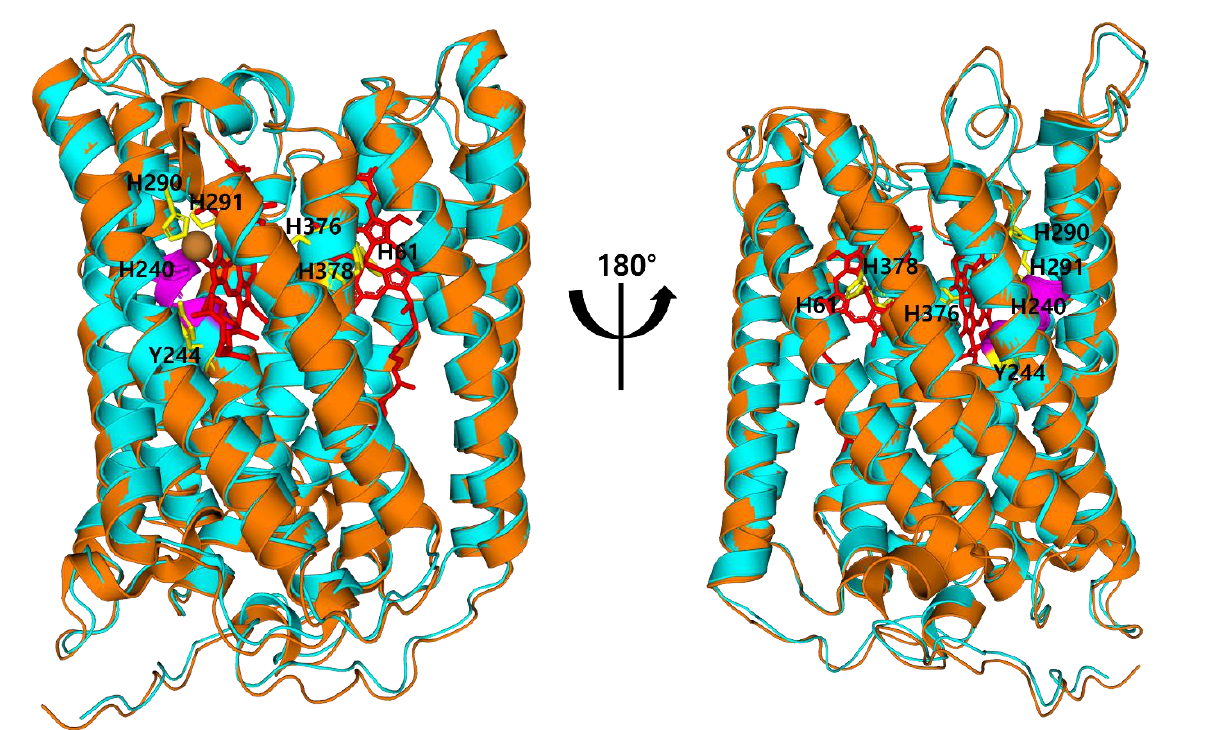
Figure 5. Comparison of predicted structure models for M. lauensis COX1 and human COX1 (PDB: 5z62). Human and M. lauensis COX1 are colored in orange and cyan, respectively. Heme-binding amino acids (yellow), heme (red), Cu B (brown), and the type A1 motif (magenta) are also shown. The type A1 motif of helix 9 comprises -XGHPEV- amino acid sequences in all species. The heme-binding regions of M. lauensis and five species have the same location as the human protein. Indeed, amino acid sequences around the heme-binding regions of all species are highly homogeneous. The type A1 motif is strictly conserved between human and M. lauensis.